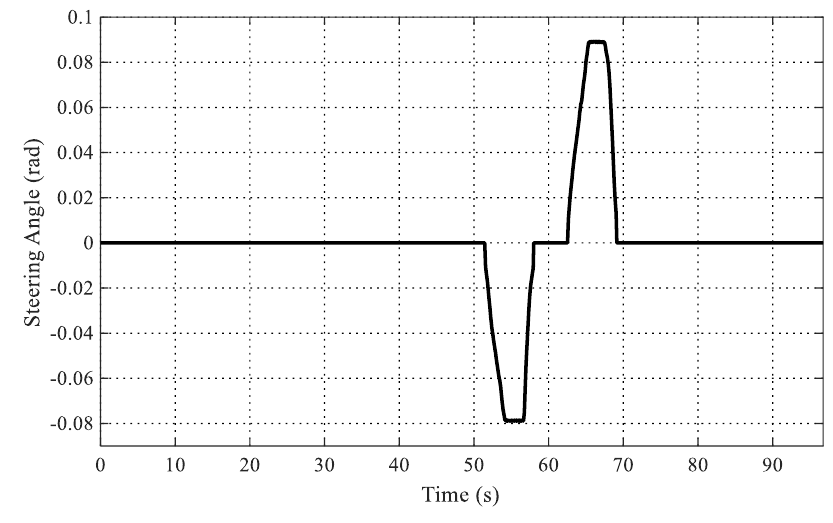
Figure 12. Steering Wheel Angle for Scenario